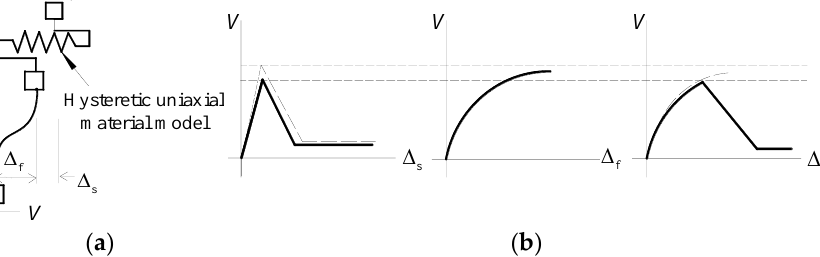
Figure 2. The shear-critical column model based on the uniaxial hysteretic material model [17]. ( a ) Model of shear–bending interaction. ( b ) The displacement response of the column caused by shear and bending